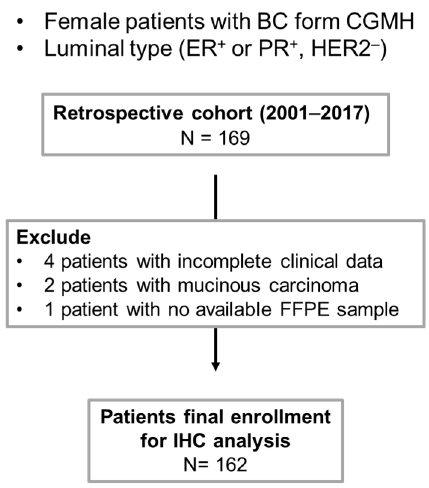
Figure 3. Flow diagram of patient selection in this study. One hundred and sixty-nine HR + /HER2 − patients who had pathologic reports and no other malignancies diagnosed in 2005–2013 were considered for this retrospective study. Seven were excluded because of incomplete clinical follow-up data ( n = 4), mucinous carcinoma ( n = 2), or no available formalin-fixed paraffin-embedded block of the primary tumor ( n = 1).